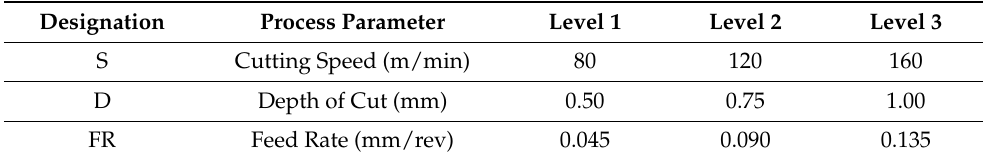
Table 3. Experimental cutting parameters with different levels for each parameter.